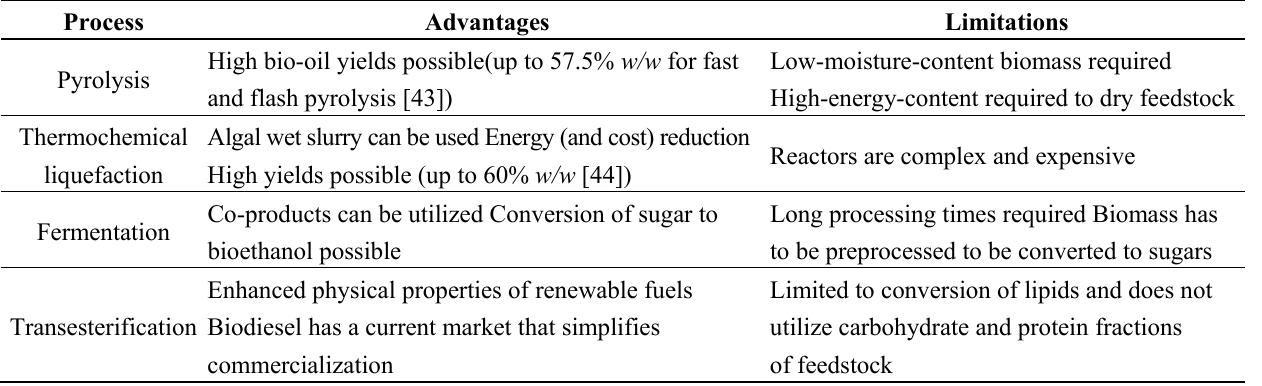
Table 1. Advantages and limitations of biofuel production processes from microalgae.